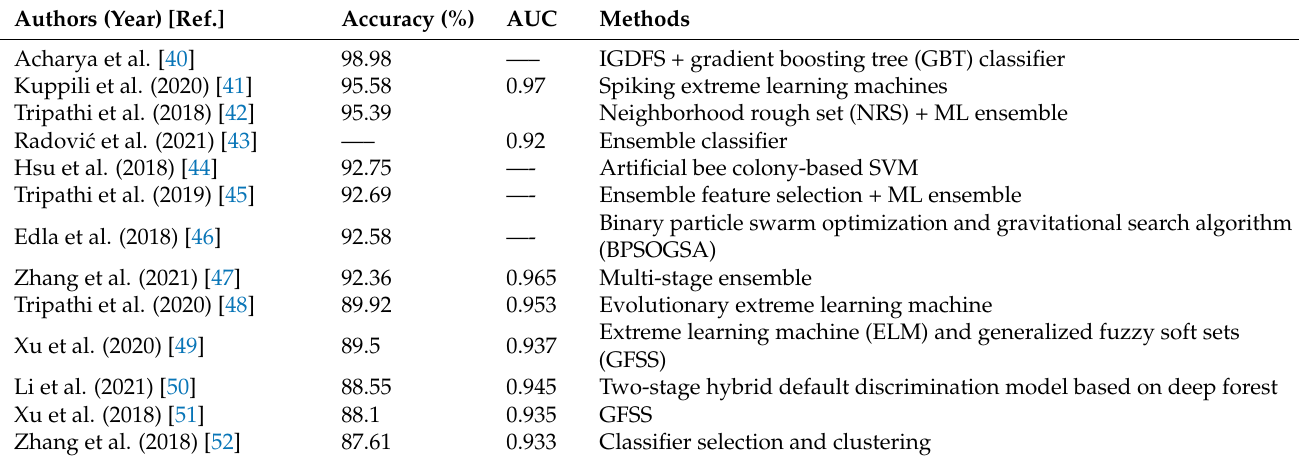
Table 2. Accuracy and area under the receiver operating characteristic curve (AUC) values of ensemble and hybrid classifiers for the Australian dataset.